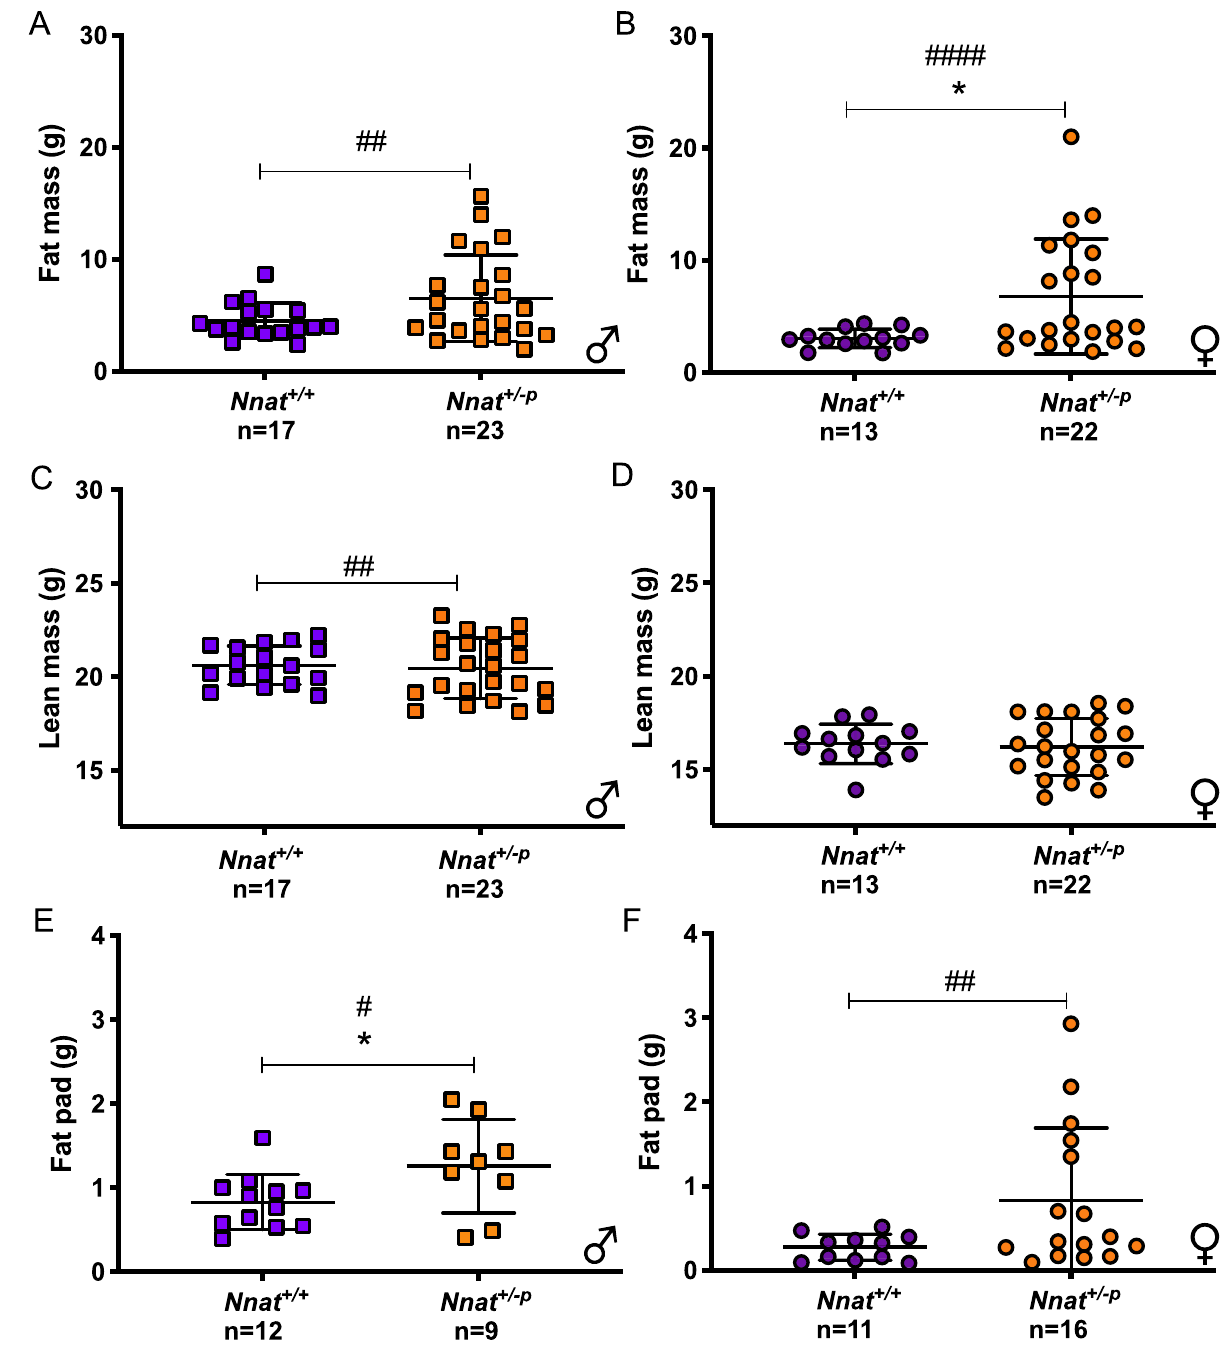
Figure 4. Nnat deficient mice display higher fat mass. Body composition analysis of fat and lean mass by TDNMR of male ( A , C ) and female ( B , D ) Nnat + / + and Nnat + /−p mice at 12–13 weeks of age fed on standard chow diet. Weight of inguinal fat pad in male ( E) and female mice ( F ). Data are expressed as mean ± SD, * P < 0.05 for Mann–Whitney test and # P < 0.05 , ## P < 0.01, ### P < 0.001 for Levine’s